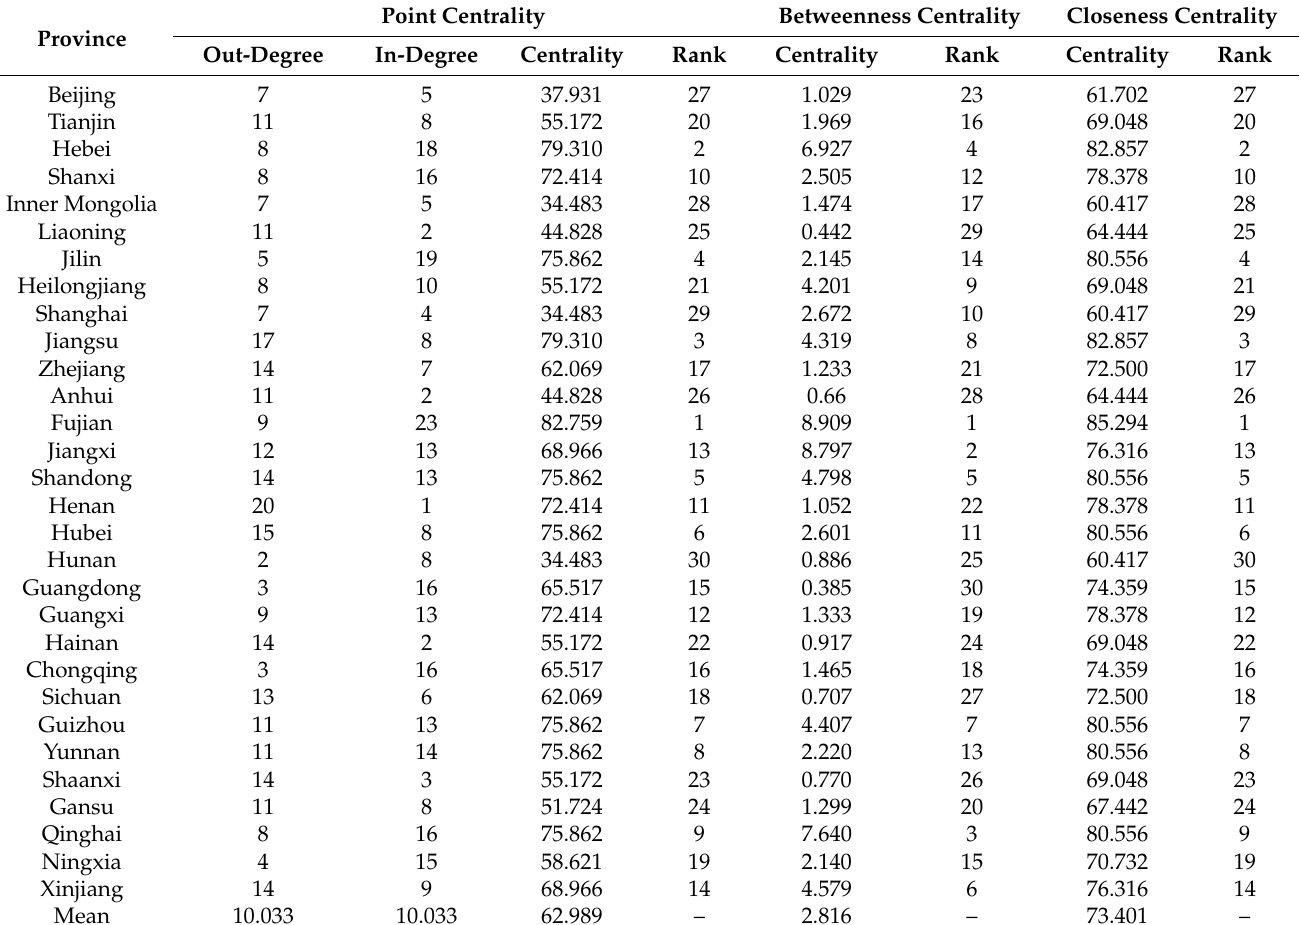
Table 4. Central analysis of spatial correlation network of agricultural water use efficiency in